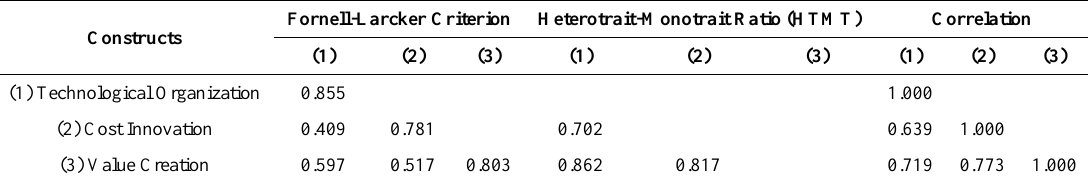
Table 4. Discriminant Validity and